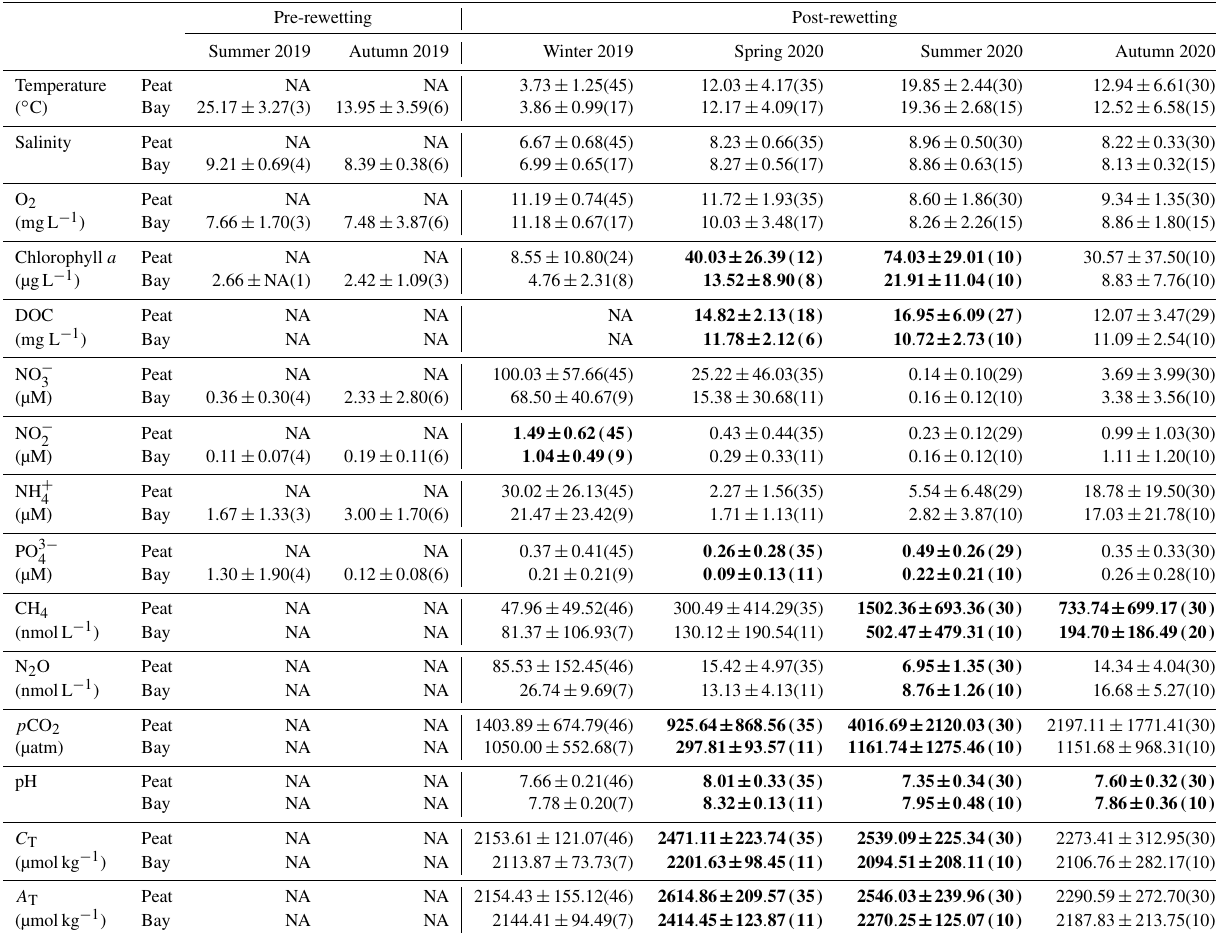
Table 2. Seasonal comparison of the surface water means ( ± standard deviation) in the peatland (Peat) as opposed to the inner bay (Bay) for all in situ variables. The number of observations is shown in parentheses, and significant seasonal differences ( p < 0 . 05) between the inner bay and the peatland are indicated in bold.